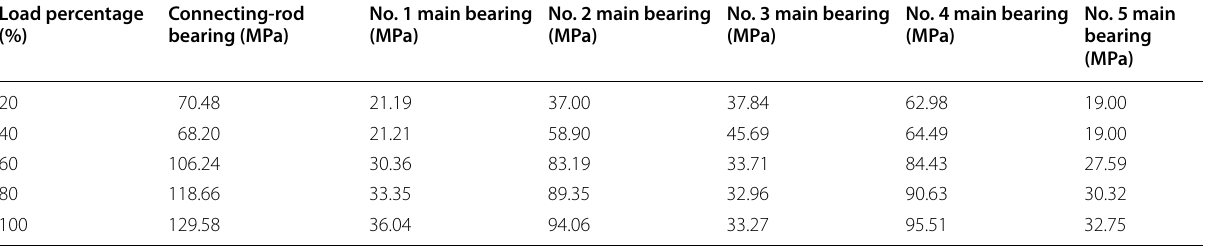
Table 7 Maximum film pressures of connecting‑rod bearing and main bearings at 2200 r/min and different load percentage Load percentage (%)